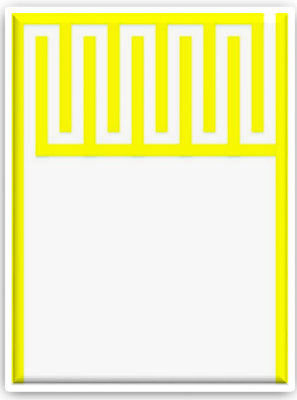
Figure 2. Schematic diagram of capacitive humidity sensor.